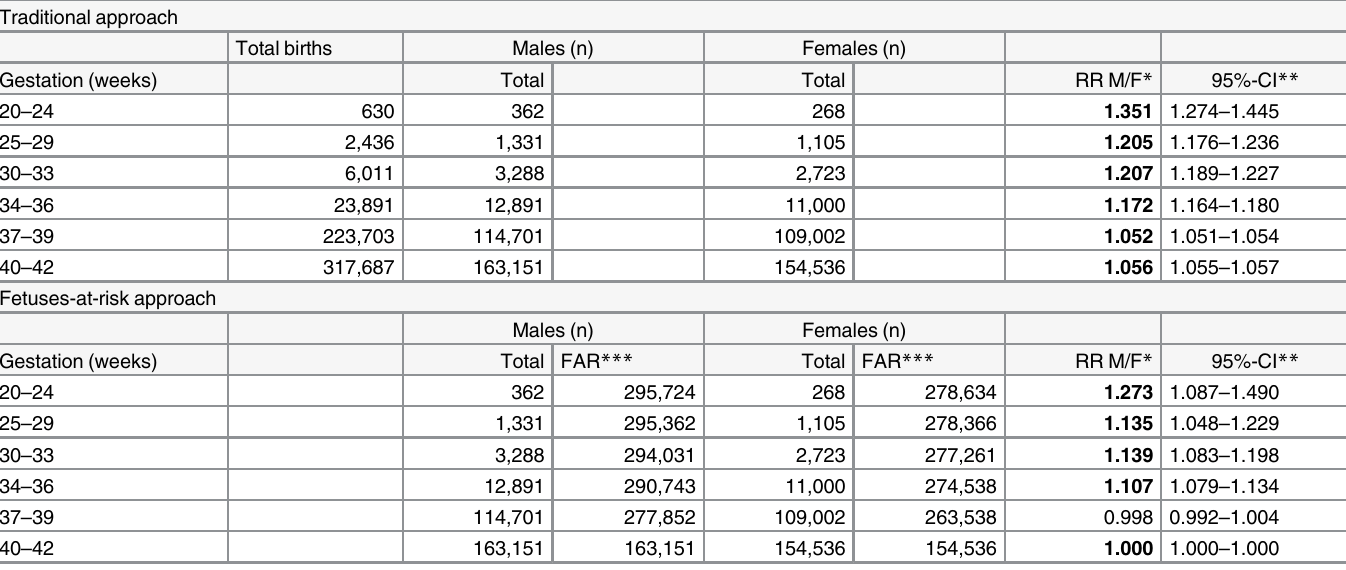
Table 2. Sexual dimorphism for length of gestation in